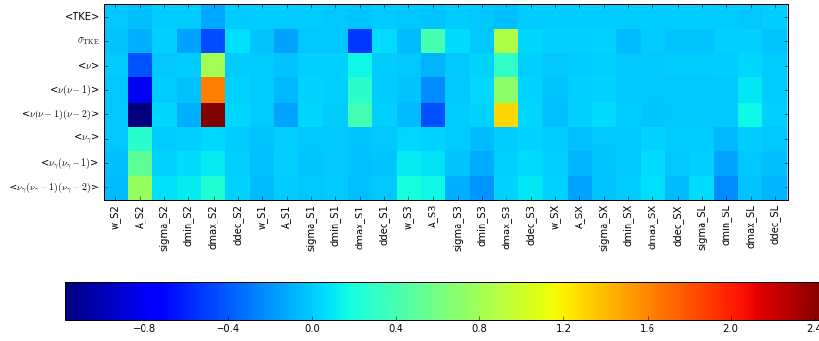
Figure 2. Responses of various observables calculated with CGMF to small changes in the Brosa mode parameters, as defined by Eq. 8.